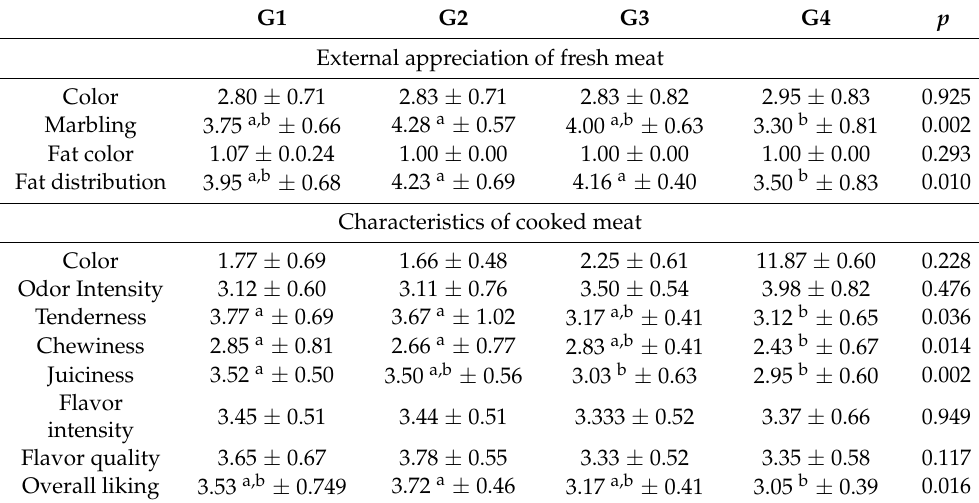
Table 7. Sensorial parameters (mean ± standard deviation) of meat from dietary experimental